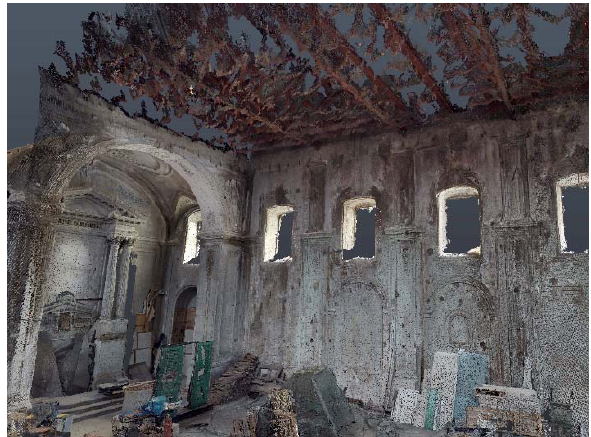
Figure 6: Indoor view of the Matterport Pro2 3D’s point cloud: note, in particular, the